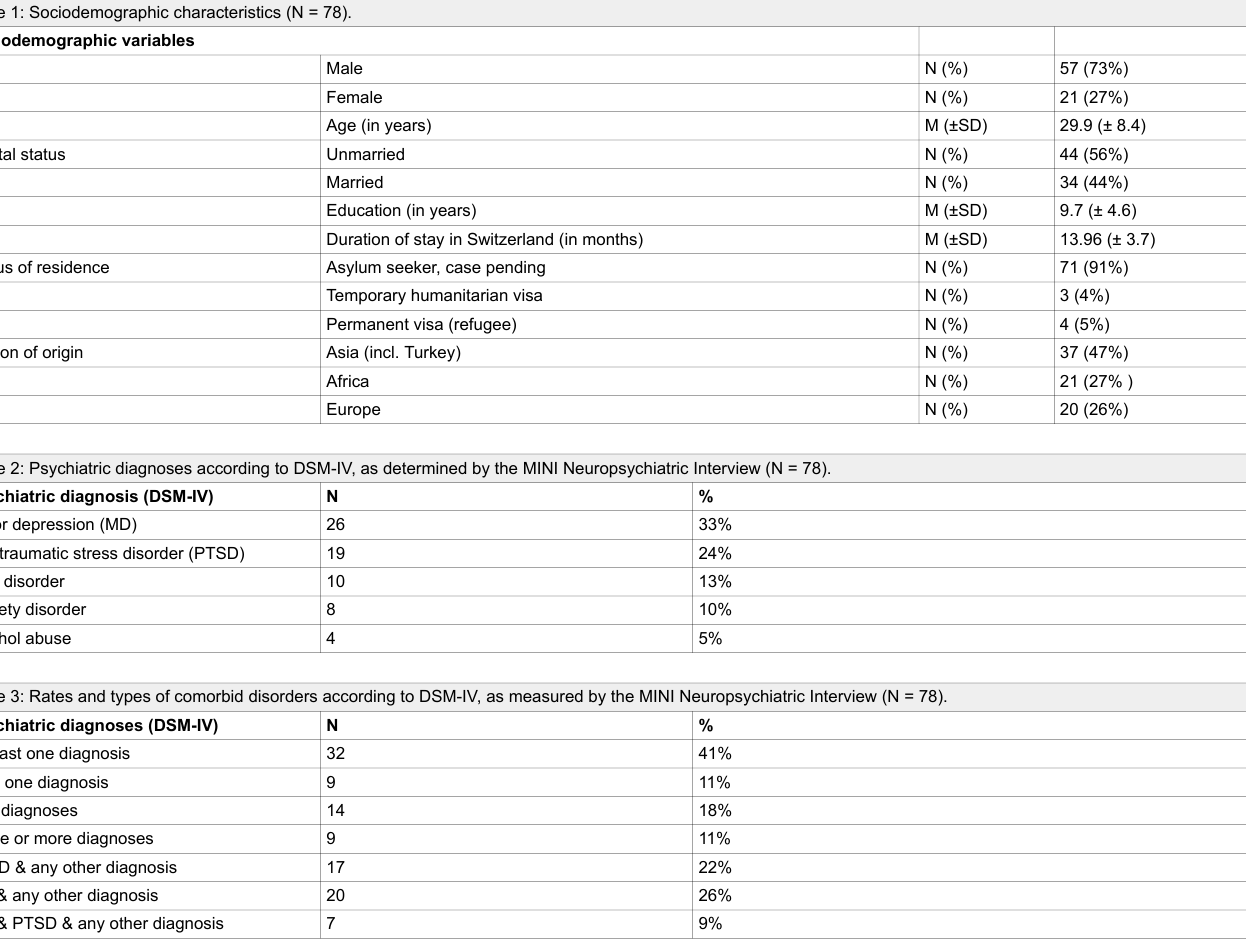
Table 1: Sociodemographic characteristics (N = 78). Sociodemographic variables